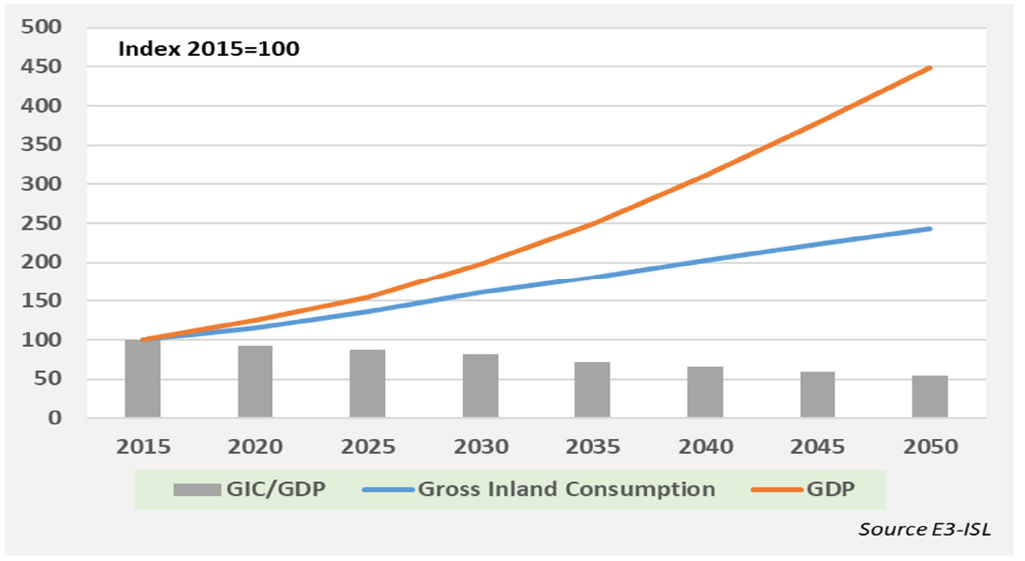
Figure 7 . Baseline—gross inland energy consumption and gross domestic product over 2015–2050 in Mayotte.